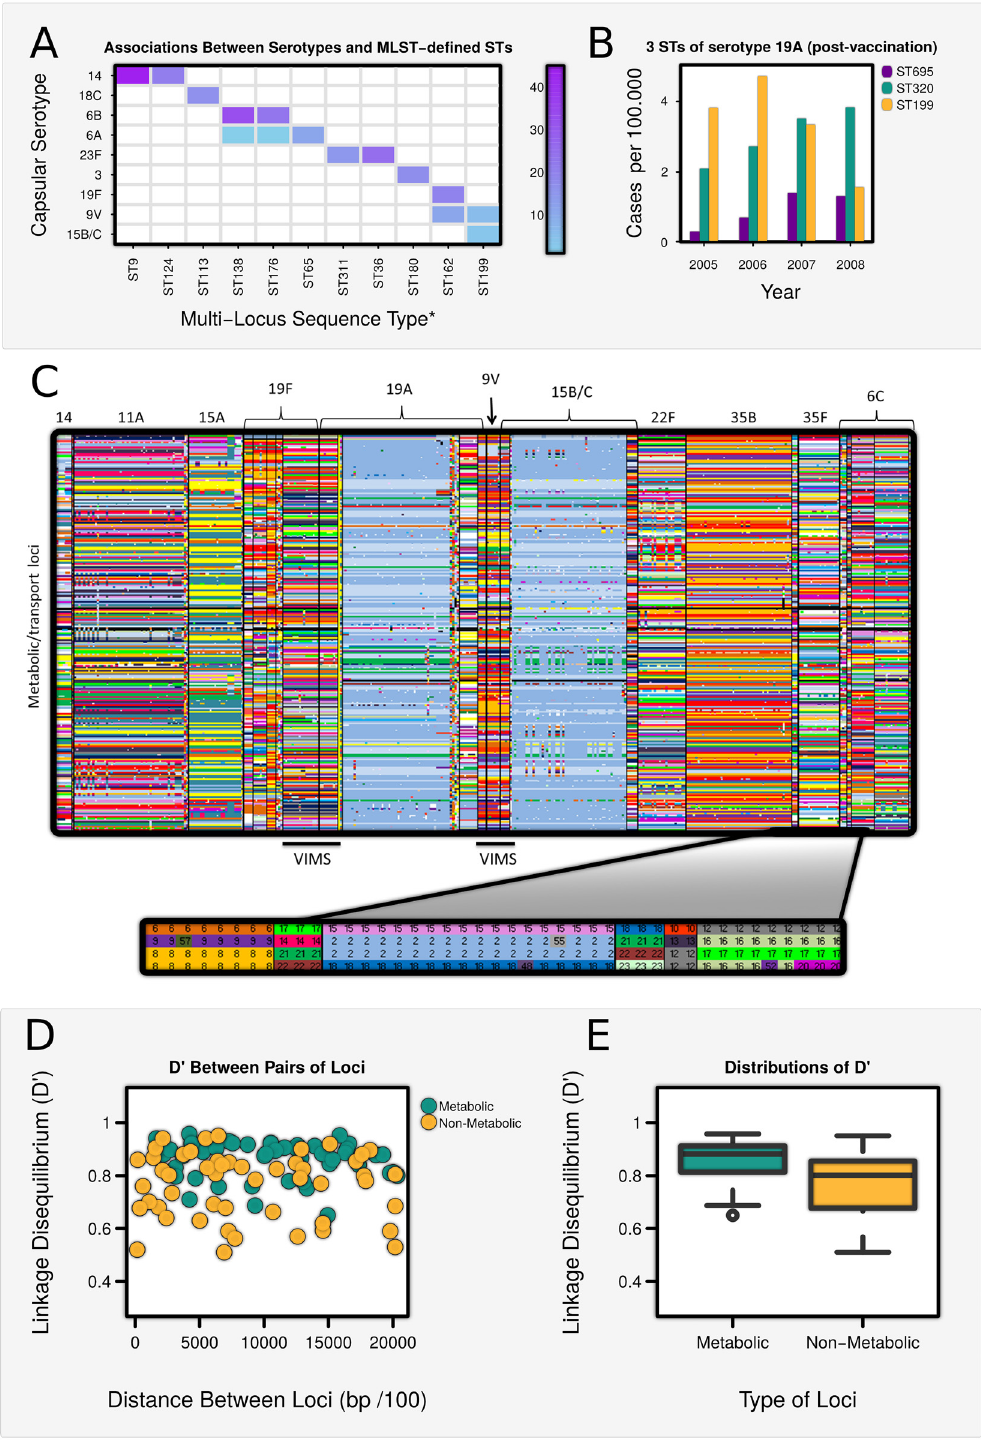
Fig 1. Shifts in associations between capsular serotype and metabolic types type following vaccination. ( A ) Associations between the most frequent pneumococcal serotypes and MLST-defined STs, England (adapted from [4]) ( B ) Disease prevalence of three STs of serotype 19A among children < 5 years in the United States, following vaccination in 2000 (adapted from [7]) (C) Partial screenshot of the metabolic profiles of 616 pneumococcal isolates (obtained from [22]) grouped by serotype (see also S1 Dataset). Each column represents the allelic profile of 876 metabolic/transport genes of a single isolate. Black bars indicate where VIMS (Vaccine-Induced Metabolic Shift) has occurred. (D) Linkage Disequilbrium (measured as D ’ ) between pairs of metabolic loci &